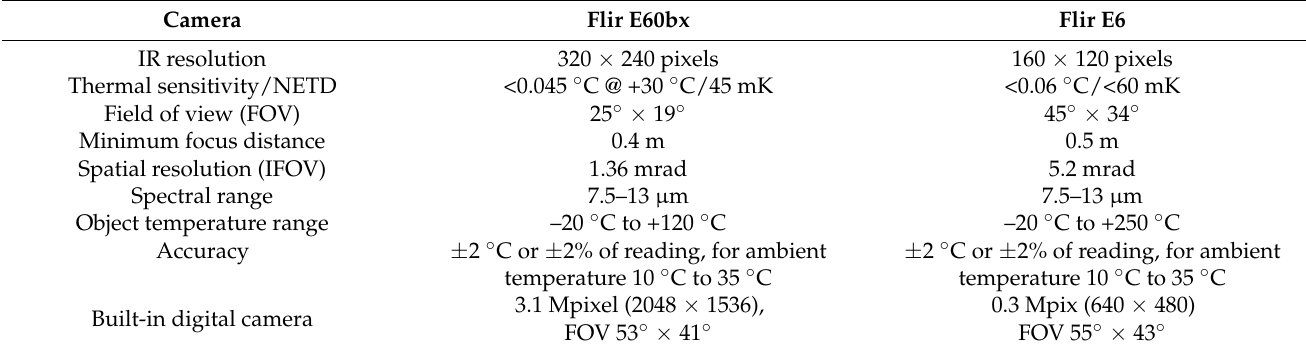
Table 2. Comparison of FLIR E60bx and E6